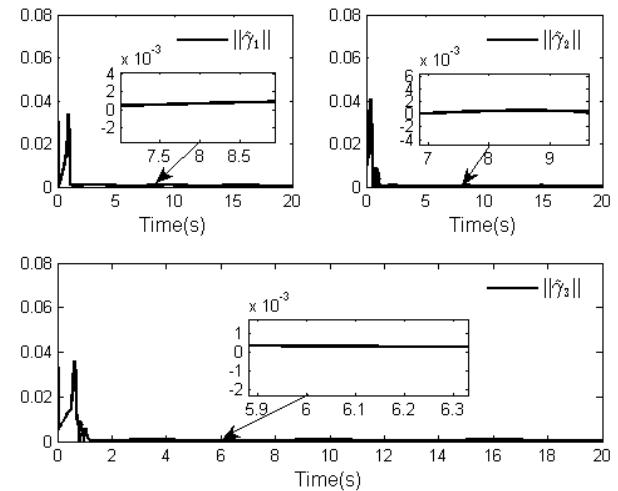
(cid:13) (cid:13) ˆ (cid:13) . (cid:13) ˆ W i W . i